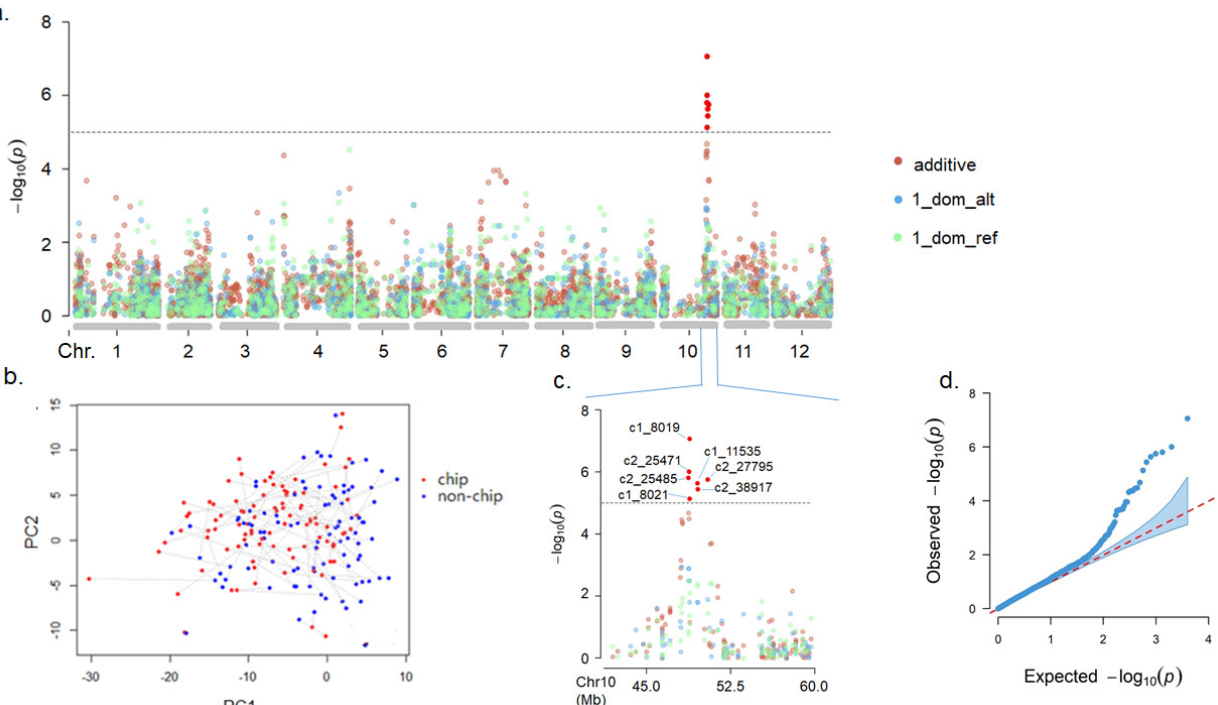
Figure 2. The genome-wide association analysis for 95 chip-processing cases and 95 controls. ( a ) Manhattan plot for 3977 SNPs, with significant SNPs highlighted in red, which was obtained using the built-in K correction function of GWASpoly R package. The x -axis shows the chromosomal position, and the y -axis shows the significance of association ( − log 10 ( p )). The horizontal line shows the genome-wide significance level ( − log 10 ( p ) = 4.9). In this study, we used the additive marker model and two simplex dominant marker models (1_dom_alt and 1_dom_ref). ( b ) Scatterplot of the first two principal components (PC) for 190 individuals derived by PCAmatchR. ( c ) Regional association plot, with SNPs annotated and highlighted in red, on chromosome 10. ( d ) Quantile-quantile plot for GWAS of additive model using 3977 SNPs. The area shaded in light blue indicates the 95% confidence interval under the null